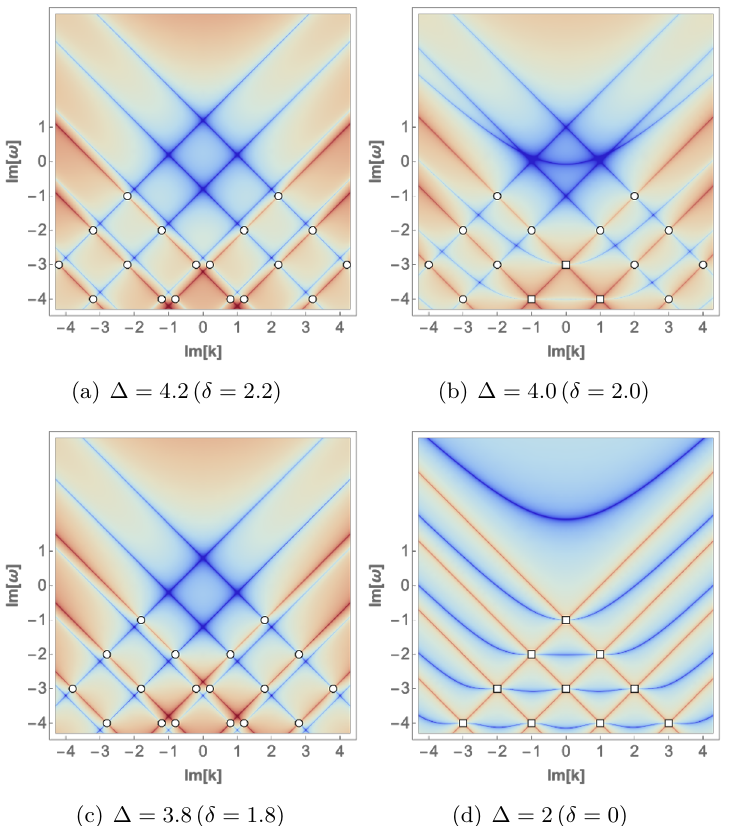
Figure 2 . log |G ∆ (Im[ ω ] , Im[ k ]) | at d = 4 . The blue lines and red lines represent zeros and poles of the Green’s function, respectively. The white circles and squares are type I and type II pole- skipping points, respectively. The meaning of the type I and II classifications will be explained in section